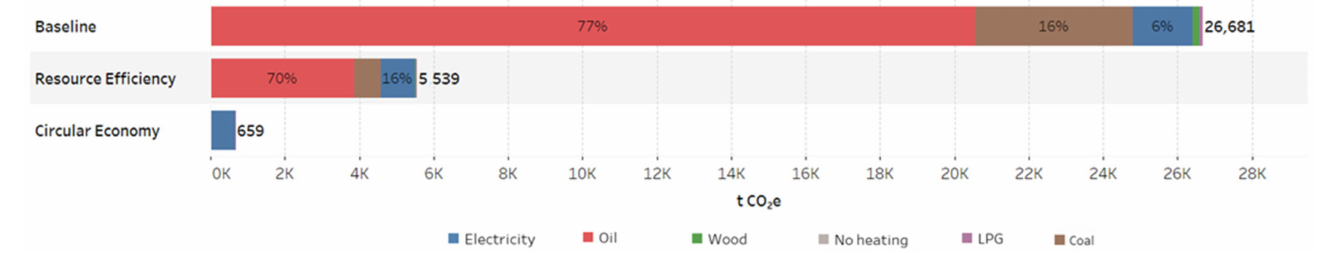
Figure 11. Comparison of current and heat pump uptake scenario GHG for house archetypes contributed by fuel type.